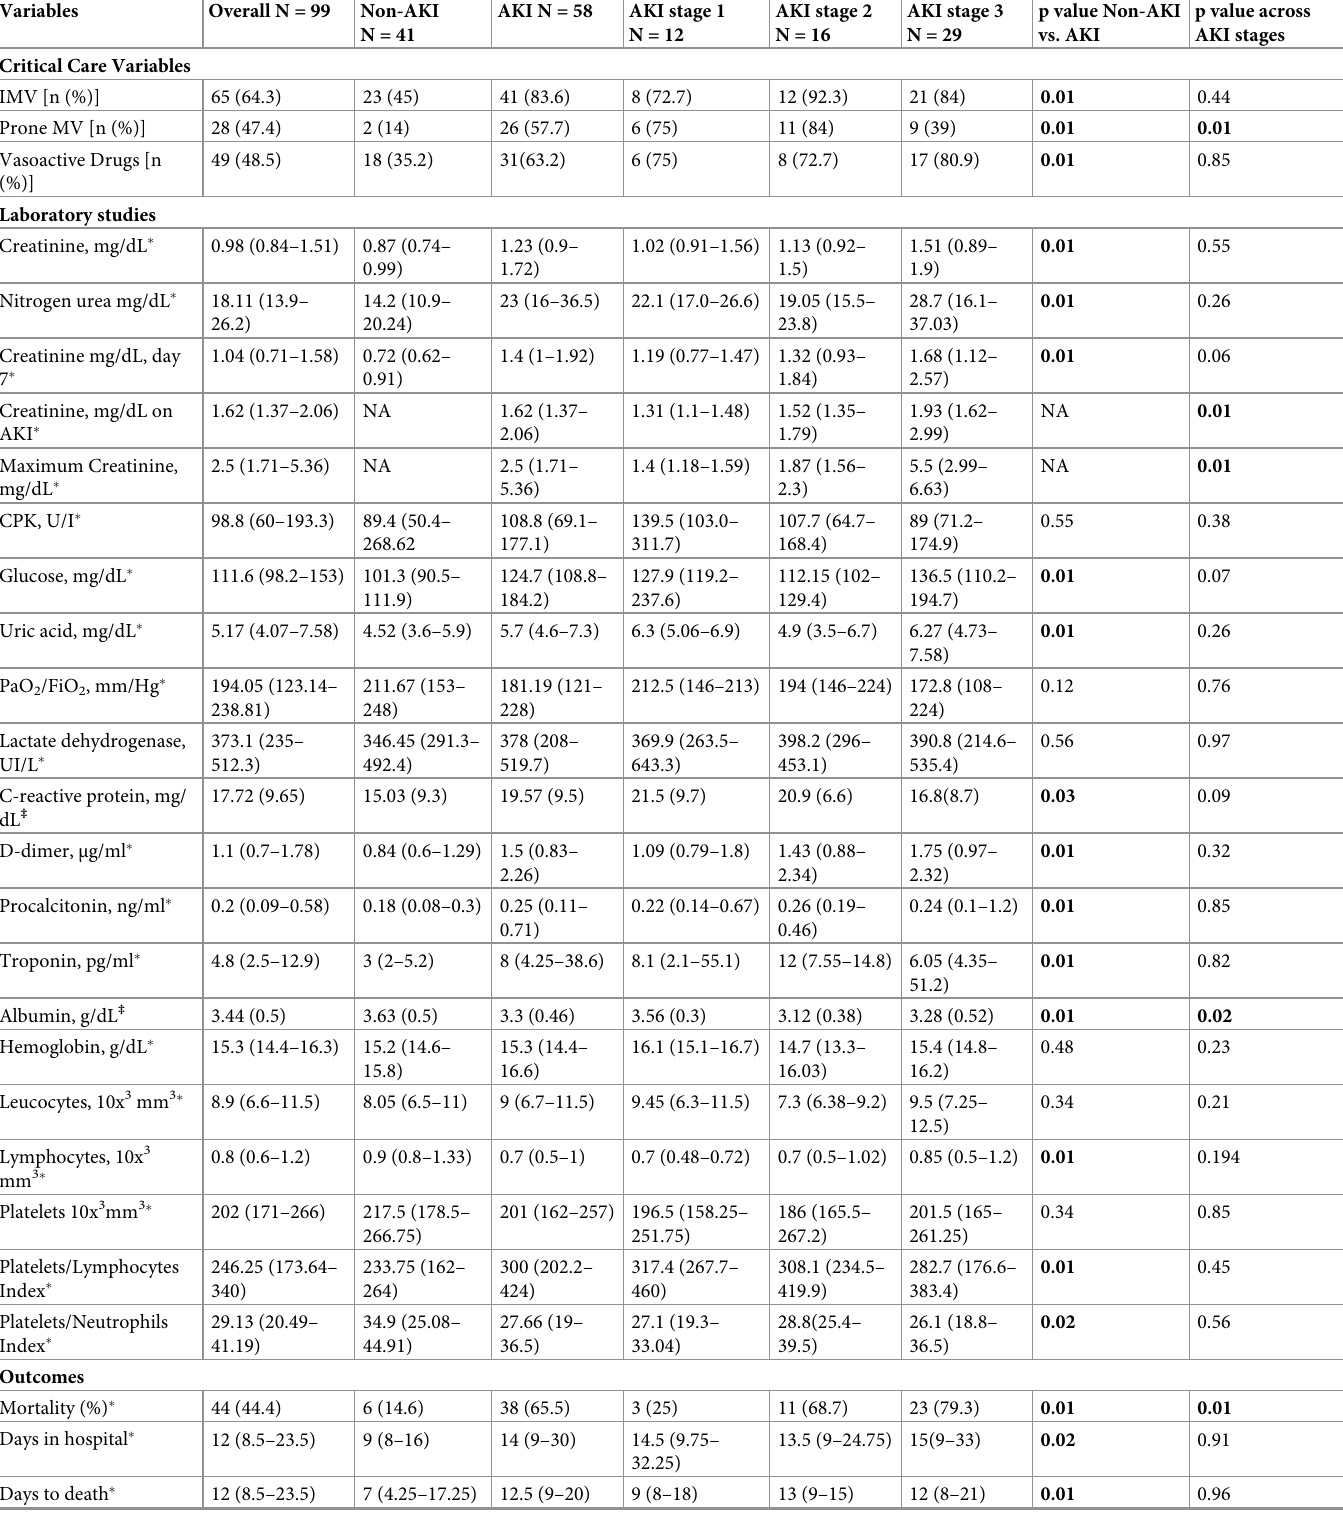
Table 2. Baseline laboratory values of the study